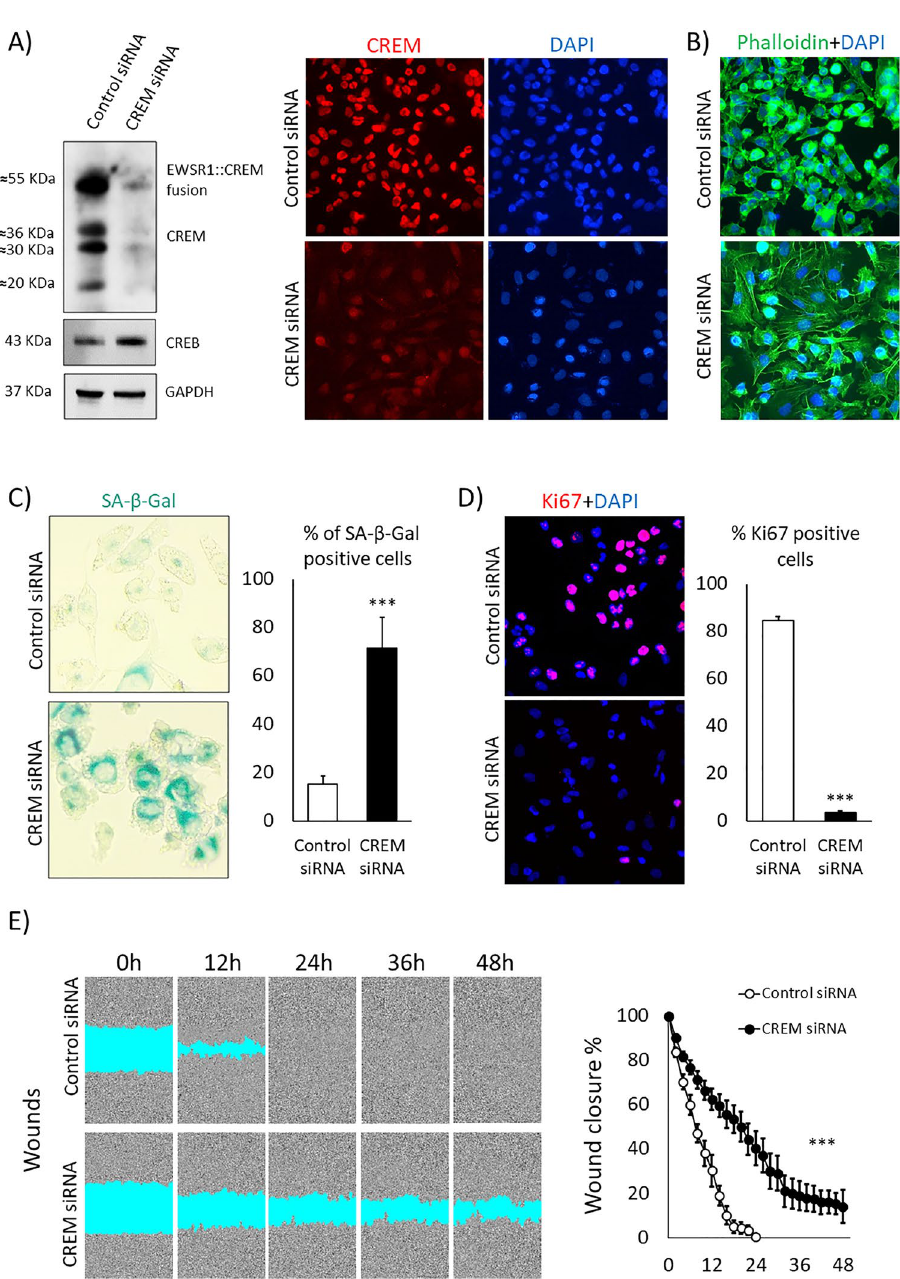
Figure 2. Effects of CREM knockdown in the CHL-1 cell line. ( A ) Western blotting and cell staining after CREM siRNA treatment. The blots are cropped and original blots can be found in Supplementary information— Original blots Supplementary Figs. S2 and S3. ( B ) Cell morphology after CREM knockdown. ( C ) Senescence assessed with SA β ‐ galactosidase staining after CREM knockdown, confirming loss of proliferation from 84 to 4%. ( D ) Immunostaining for the proliferation marker Ki67 after CREM siRNA treatment. ( E ) Wound healing assay after CREM knockdown. *** P ≤ 0.001 ( t